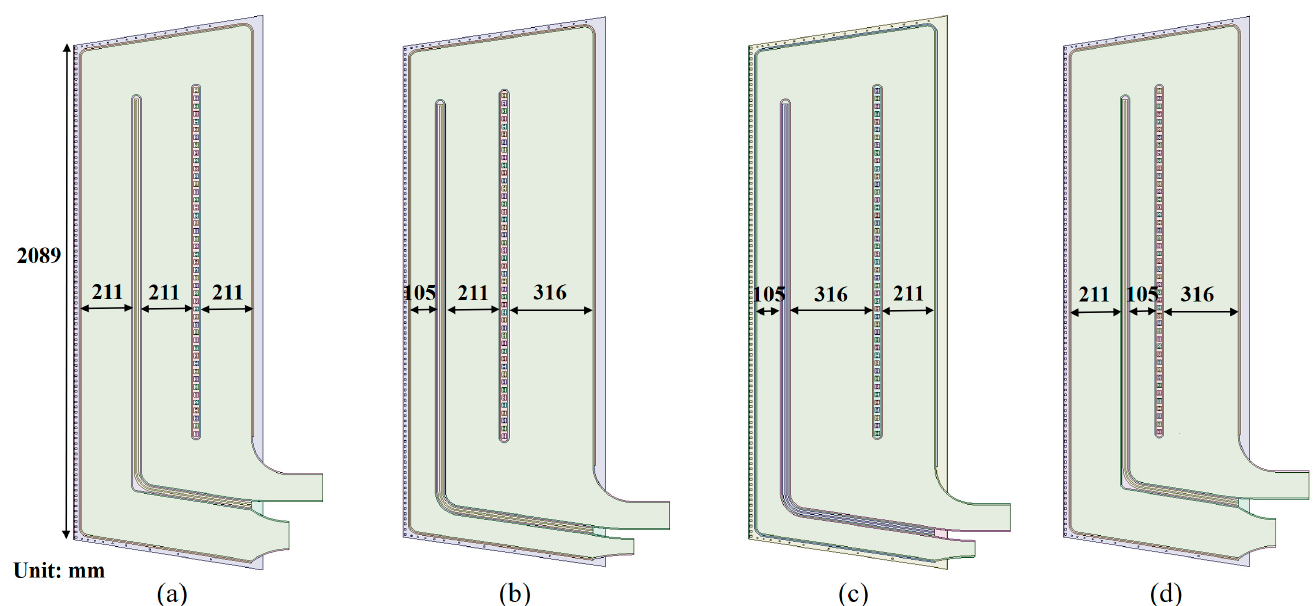
Figure 17. Three structure designs for optimization ( a ) 1:1:1; ( b ) 0.5:1:1.5; ( c ) 0.5:1.5:1; ( d )1:0.5:1.